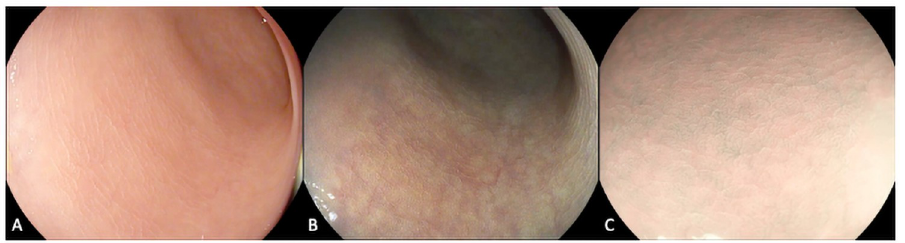
Fig 1. Endoscopic assessment of IBD. Colonic mucosa was examined using high-definition white light and virtual electronic chromoendoscopy demonstrating vascular and mucosal architecture of healing using a) iScan 1 b) iScan 2 c) iScan Optical